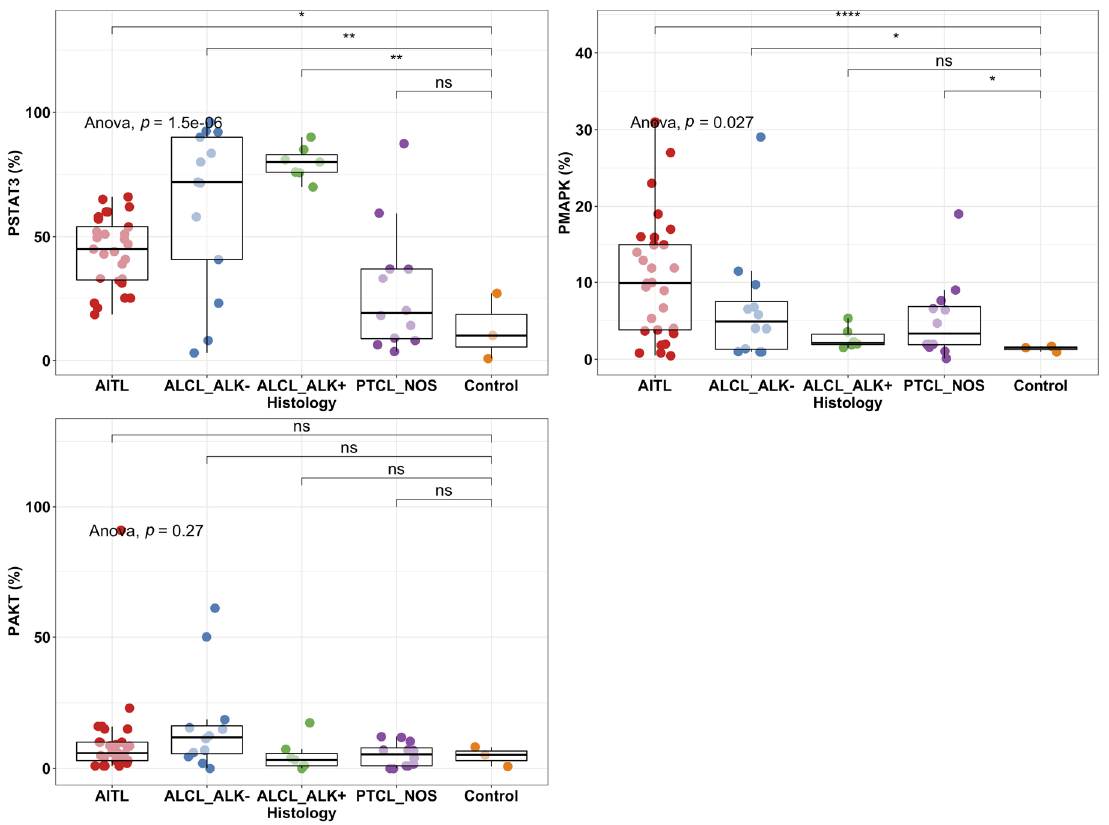
Figure 2. Phosphorylation percentage of pY-STAT3, MAPK, and AKT in PTCL subgroups and healthy controls ( n = 2–3) analyzed by immunohistochemistry. Individual dots represent the proportion of positive cells for pSTAT3, pMAPK, and pAKT. Boxplots represent the median and interquartile range of protein phosphorylation levels. The antibodies used were specific for Tyr705 (pStat3), Thr202/Tyr204 (pMAPK), and Thr450 (pAKT). Comparison was analyzed with ANOVA and post-hoc tests between disease groups and healthy controls. *: p < 0.05; **: p < 0.01, ****: p < 0.0001; ns: not significant.